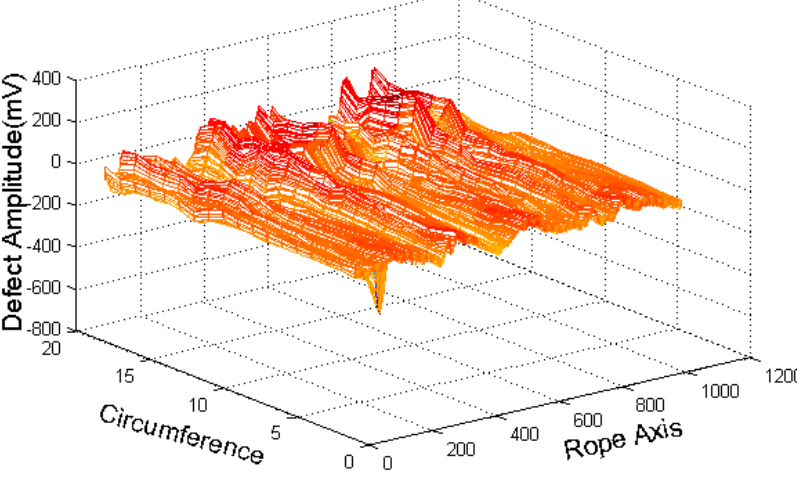
Figure 5. Unrolled preprocessed signals.